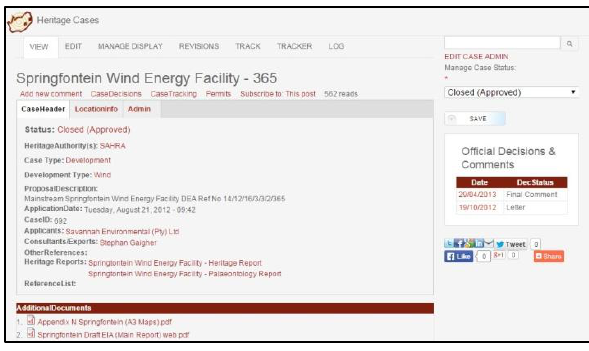
Figure 4: Example of a development application on SAHRIS